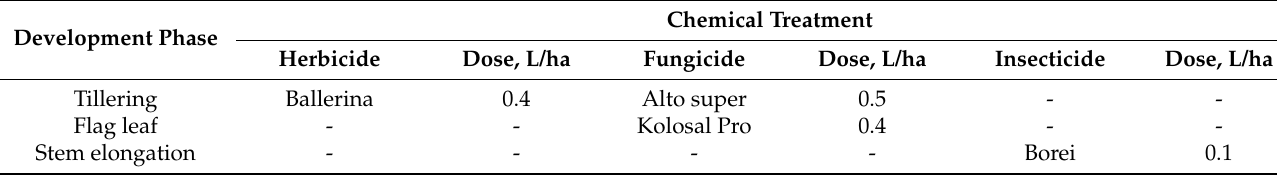
Table 1. Scheme of phytosanitary treatment by plant development phases of winter wheat.